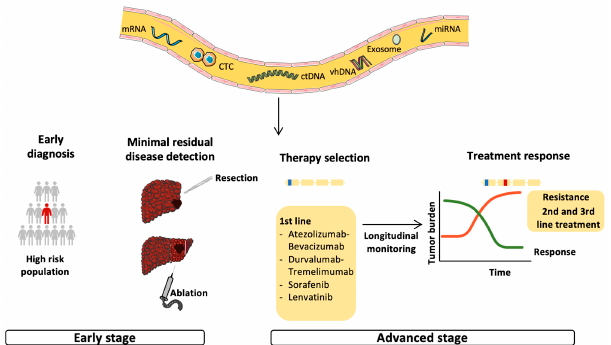
Figure 2. Possible applications of circulating tumor DNA in the management of HCC. Circulating tumor DNA (ctDNA) reflects tumor burden and has been tested for early cancer detection and min ‐ imal residual disease (MRD) monitoring in the early stage of HCC. In addition, ctDNA should be evaluated for the identification of targetable mutations and biomarkers and, therefore, be used for therapy selection. The non ‐ invasiveness and the ability to reflect the patient’s oncological picture in real time makes ctDNA an ideal tool for longitudinal monitoring and early detection of acquired resistance, leading to a switch to second ‐ or third ‐ line therapy.